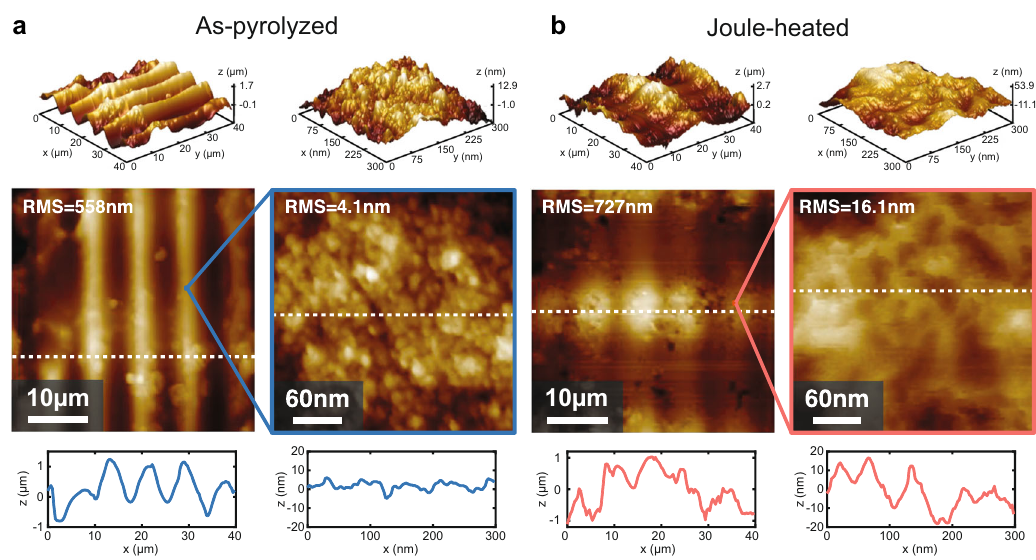
Fig. 2 Surface structural characterization with AFM. Scans of a representative as-pyrolyzed ( a ) and Joule-heated ( b ) carbon microlattice strut at the magni fi cations of 40 µ m × 40 µ m and 300 nm × 300 nm. Each column contains a 3D image of the textured beam surface, its 2D representation, and the height pro fi le extracted from the white dotted line in the 2D illustration. AFM images convey that Joule heating treatment enhanced surface roughness. From low magni fi cation images, the root mean square (RMS) peak-to-valley groove depth increases from 558 nm for as-pyrolyzed sample to 727 nm for Joule-heated specimen. High magni fi cation analyses reveal the development of homogeneously distributed nanopores introduced by Joule heating and testi fi ed by an RMS nanotopology that nearly quadrupled, rising from 4.1 nm in as-pyrolyzed sample to 16.1 nm in Joule-heated specimen.